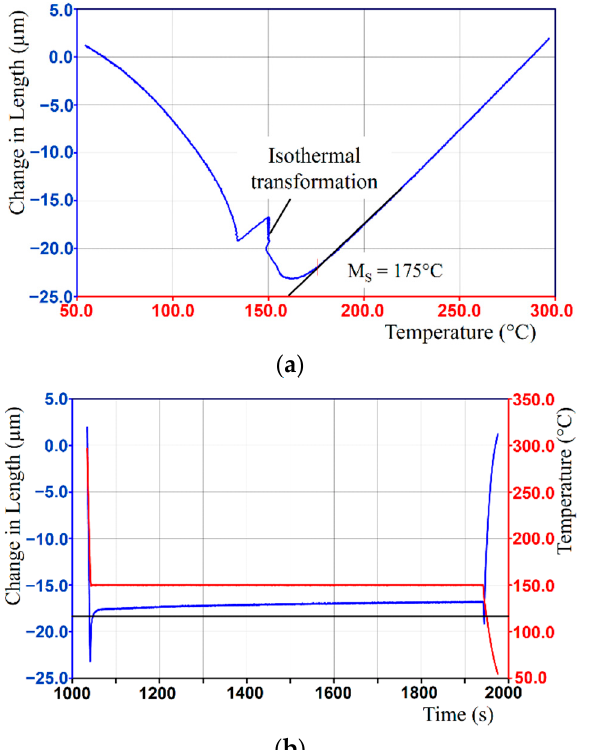
Figure 7. Results for dilatometric tests for bearing steel under isothermal conditions below M S temperature: ( a ) details of the isothermal transformation and ( b ) an enlarged view of the region of complete thermal cycle.